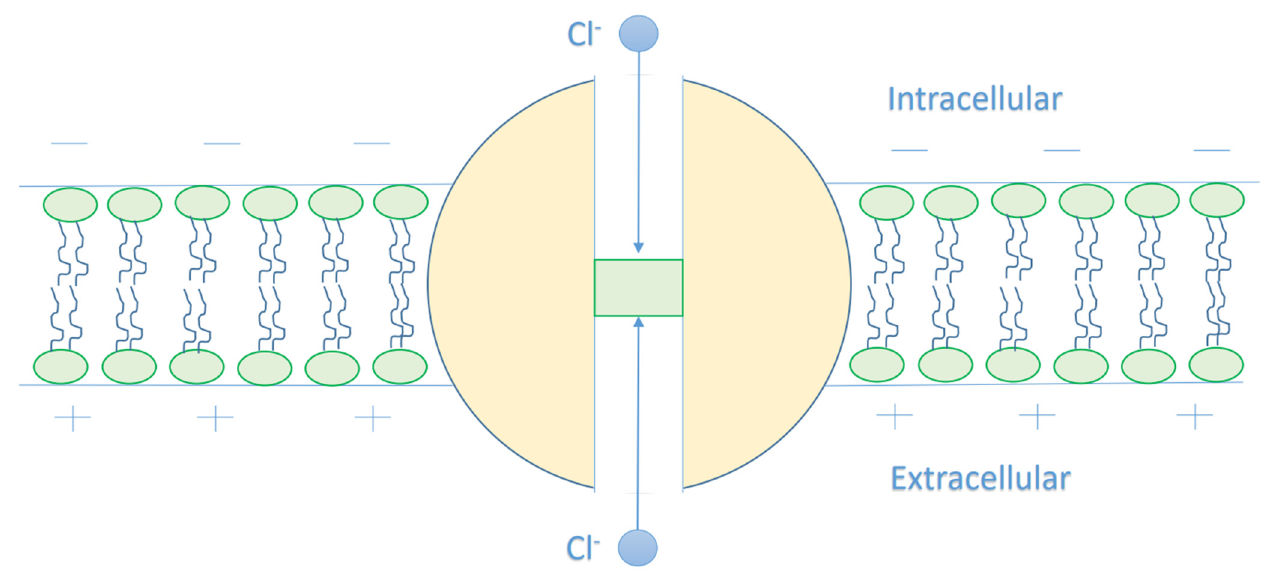
Figure 2. The figure represents a schematic diagram of chloride ion movement in the GABA receptor. The intracellular chloride ion moves from the negative side of the membrane towards the positive side, and this increases its kinetic energy until hitting the closed gate in the center of the GABA receptor, while the extracellular chloride ion moves from the positive side towards the negative side and this decreases its kinetic energy until hitting the closed gate.